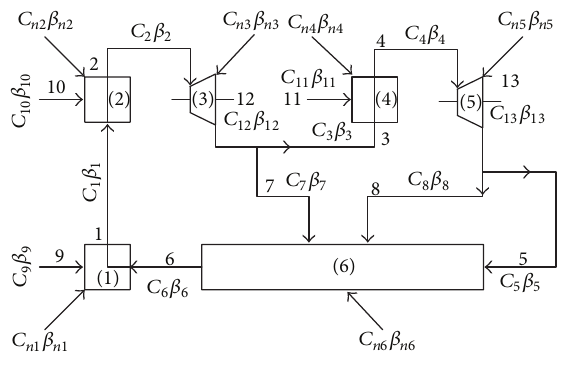
Figure 4: The schematic of cost flows.